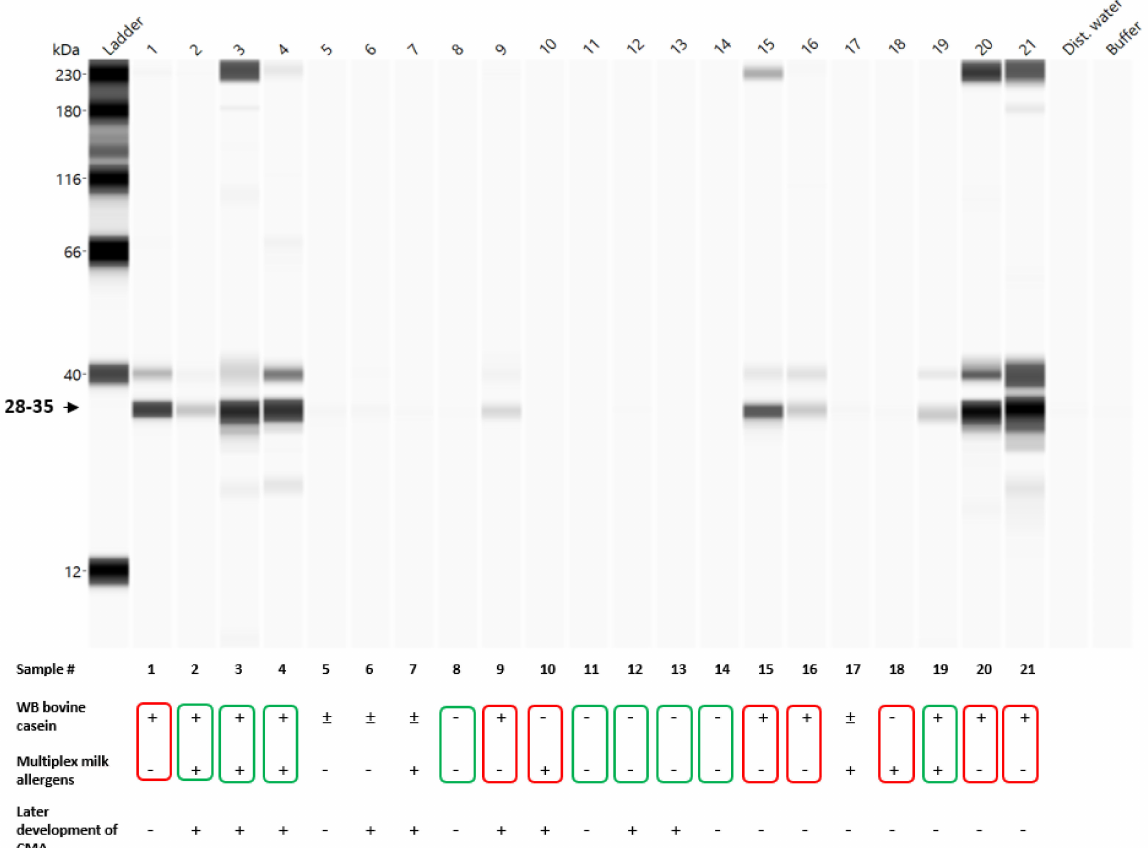
Figure 5. Western blot JessTM using full-length bovine casein. Western blot with bovine casein containing α , β , and κ -casein isoforms (95% purity) was used as a validation method for the detection of sIgE in neonatal fecal samples. The CMA status at the age of 1 and the results of the sIgE detection with multiplexed milk allergens are shown. Intermethod agreement (green frame) was found in nine samples; disagreement (red frames) was found in eight samples. Four samples were not considered for the intermethod agreement assessment due to low WB IgE